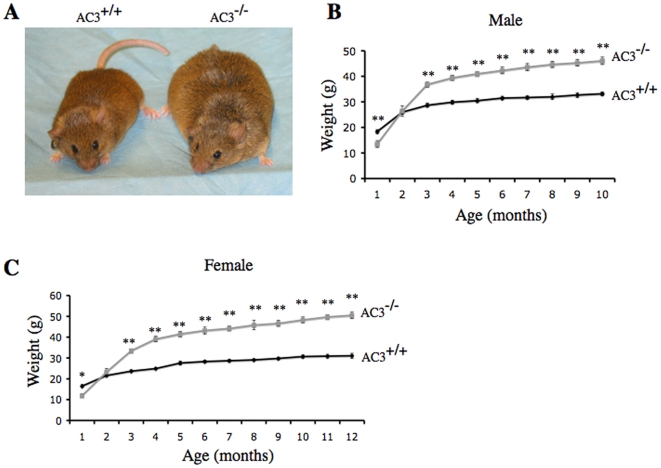
AC3−/− mice exhibit adult onset obesity.(A) Representative eight-month-old AC3+/+ and AC3−/− male mice. (B) The growth curve of AC3−/− male mice compared to AC3+/+ male mice. (C) The growth curve of AC3−/− female mice compared to AC3+/+ female mice. At each time point, the data are the average of 16 mice. Data are represented as means±SEM. *, p<0.05; **, p<0.01.